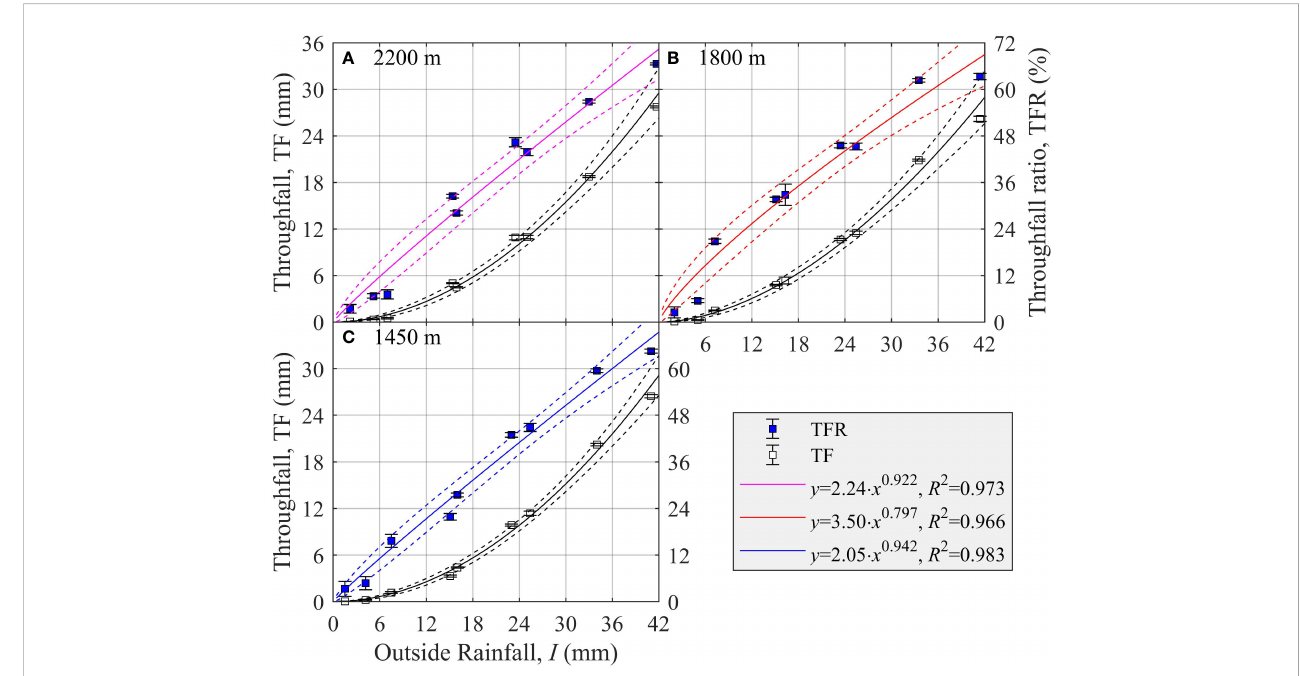
FIGURE 1 The changes in crown throughfall (TF, mm) and throughfall ratio (TFR, %) of Picea schrenkiana as a function of outside rainfall ( I , mm) at three elevation sites at the northern slope of Mount Bogda, Tianshan Range, Xinjiang, China ( N = 9). Error bars indicate the standard error of the mean ( N = 9). Dashed lines are the upper and lower 95% predicted